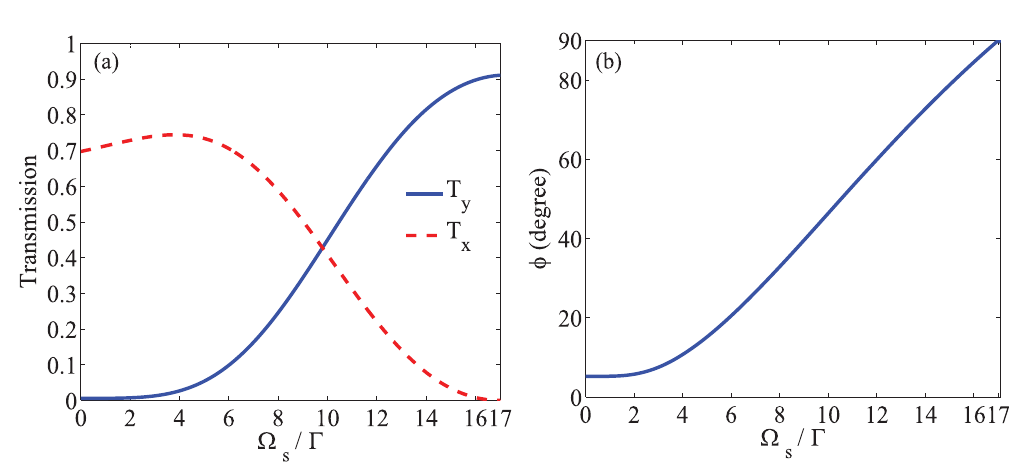
Figure 6. Intensity of the transmission ( a ) in ˆ x (dashed) and ˆ y (solid) directions and MOR angle ( b ) versus intensity of the acoustic field. The used parameters are Ω = . Γ 0 01